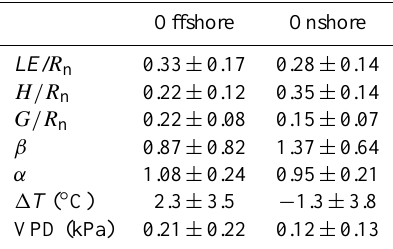
Table 2. Differences in midday (12:00 through 16:00) energy bal- ance partitioning, bulk parameters, and air conditions during off- shore (from land to ocean) and onshore (from ocean to land) winds at the CM site during the thawed season, 1999–2003. The tem- perature gradient ( 1 T ) represents the air minus the ground surface temperature (sensor located at 1cm depth).